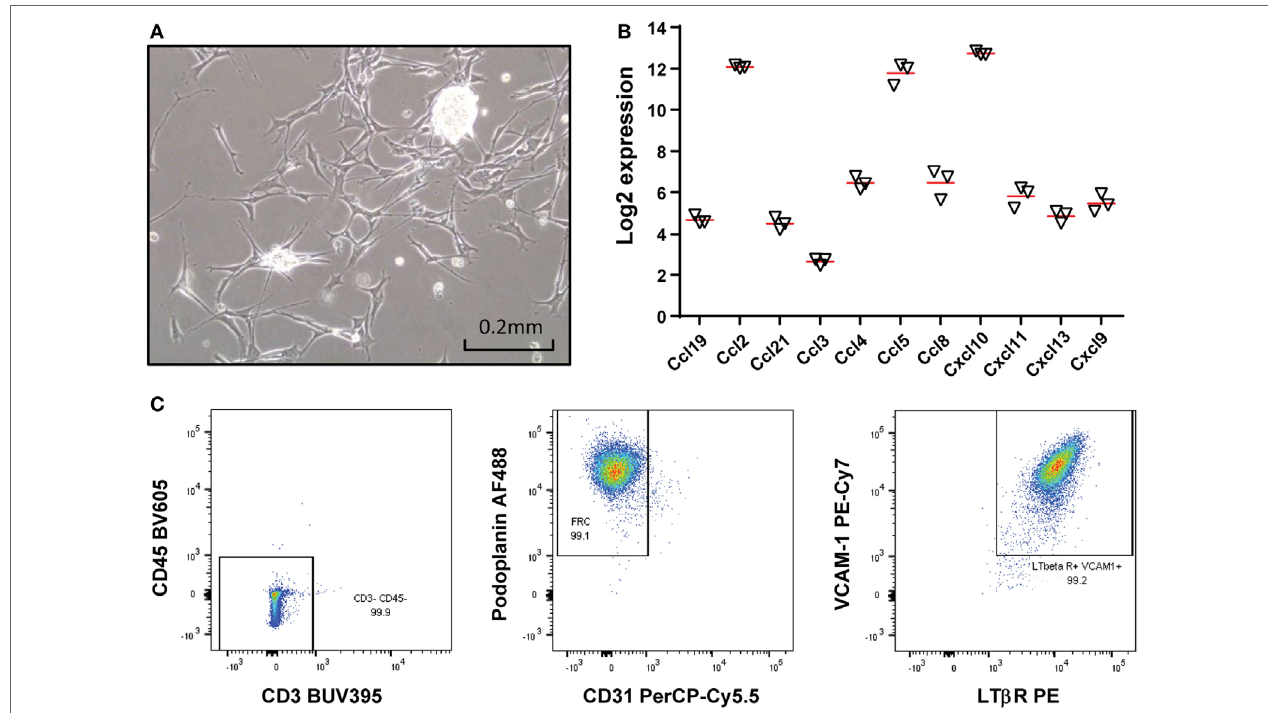
FigUre 1 | Establishing a lymph node (LN)-derived stromal cell line. (a) A photomicrograph of a LN-derived monoclonal stromal cell line (#2) in culture. Monoclonal cell lines were generated by limiting dilution. Scale bar denotes 0.2 mm. (B) Total RNA was extracted from the stromal cell line (#2) at 3 different passages and mRNA level of indicated 11 chemokines were analyzed by mouse genome arrays. Log2 transformed data were presented and red bars denote the mean. (c) The stromal cell line was stained for CD3, CD45, CD31, podoplanin, LT β receptor (LT β R), and vascular cell adhesion molecule 1 (VCAM-1), and analyzed by flow cytometry. The majority of the cells are fibroblastic reticular cells with expression of VCAM-1 and LT β